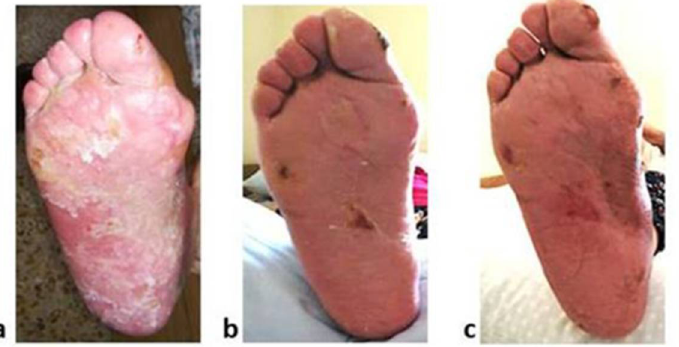
Figure 1. Pictures of grade 4 HFS developed by patient 2. The pictures were taken at different times: ( a ) after 15 cycles of capecitabine when the patient was concomitantly assuming folate sup- plementation; ( b ) following discontinuation of capecitabine and folate supplementation; ( c ) after capecitabine restarting.